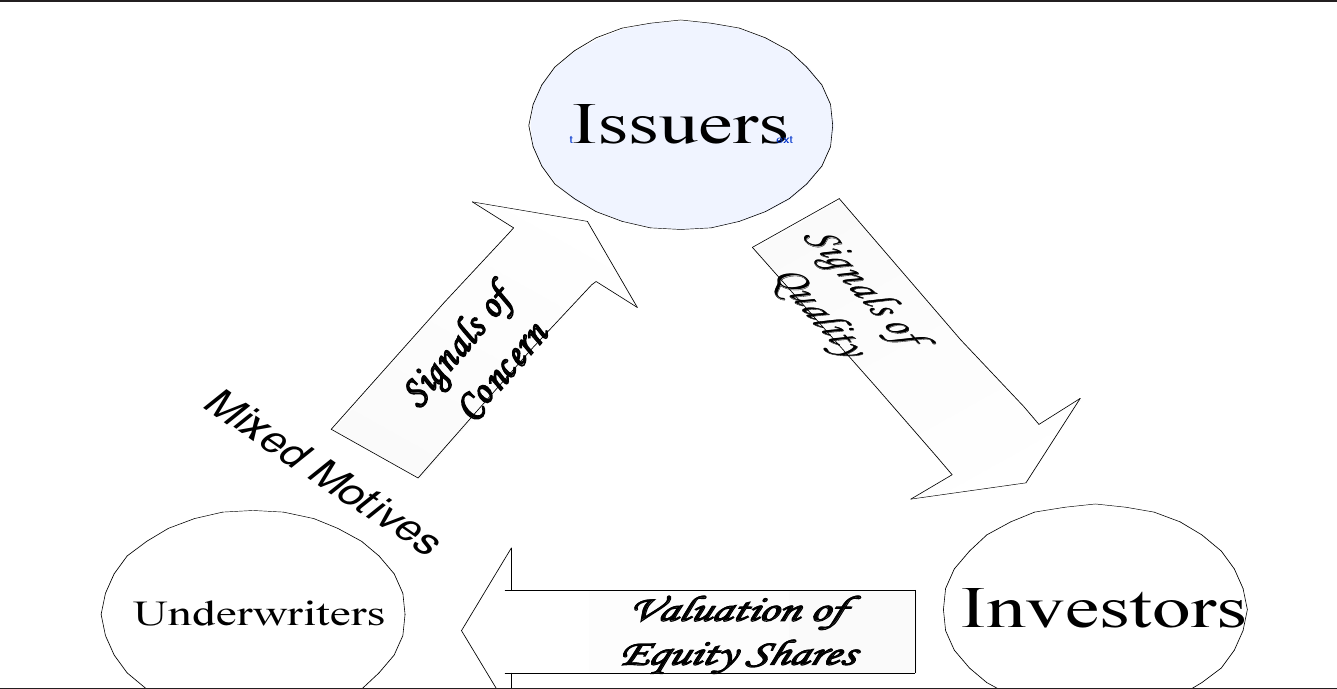
Figure 2. Iterative 3-way Communication of